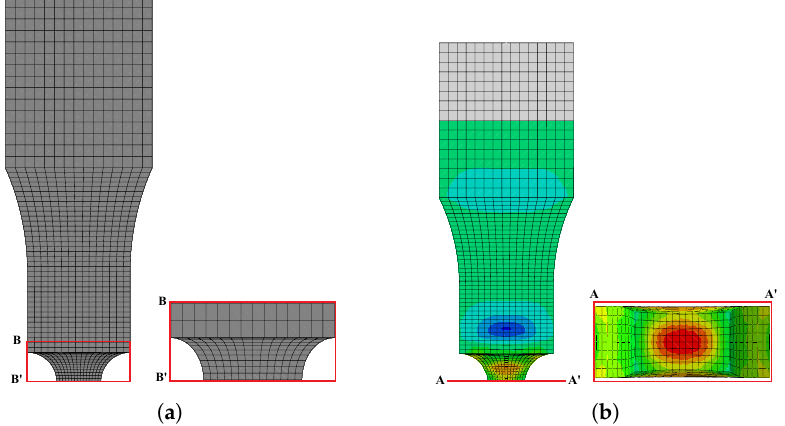
Figure 8. Finite element models. ( a ) Fine mesh in notching region; ( b ) Stress estimation